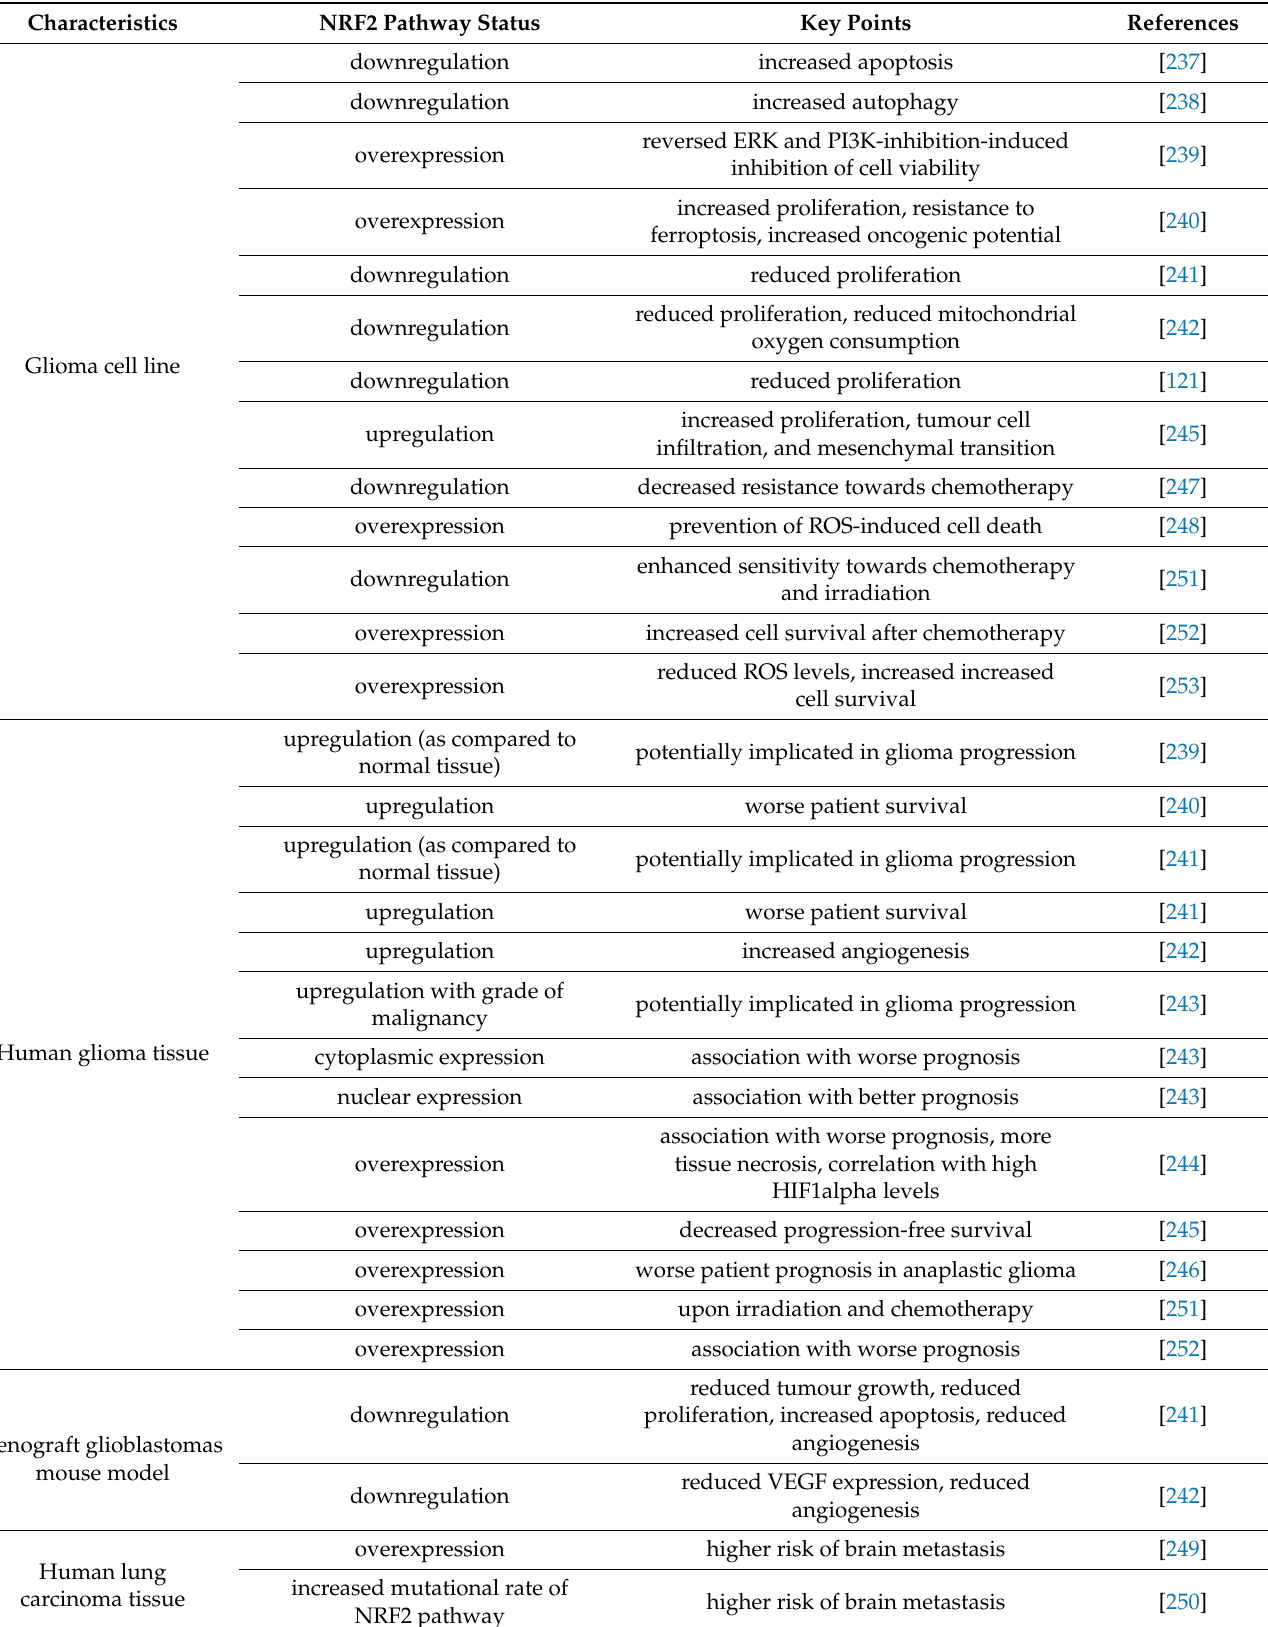
Table 5. NRF2 and